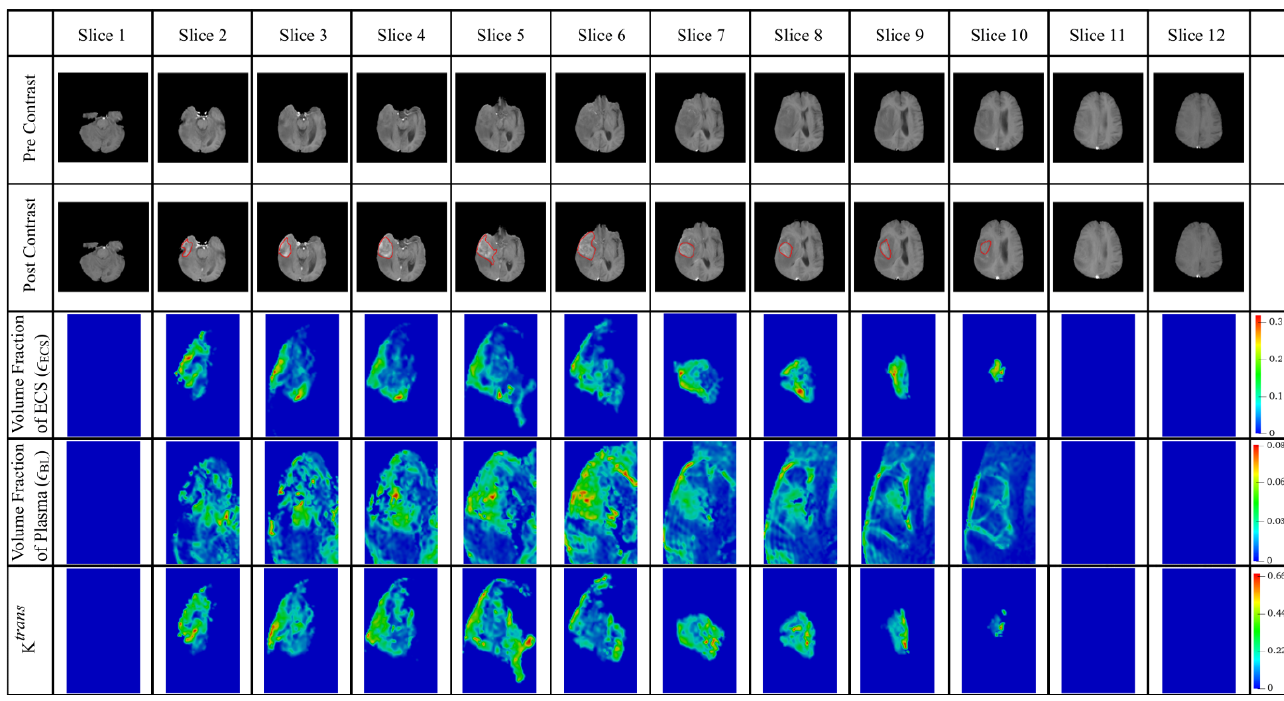
Figure 3. Tissue heterogeneous properties extracted from patient DCE-MR images. The interface between the brain tumor and its holding tissue is marked in red in the post-contrast images.